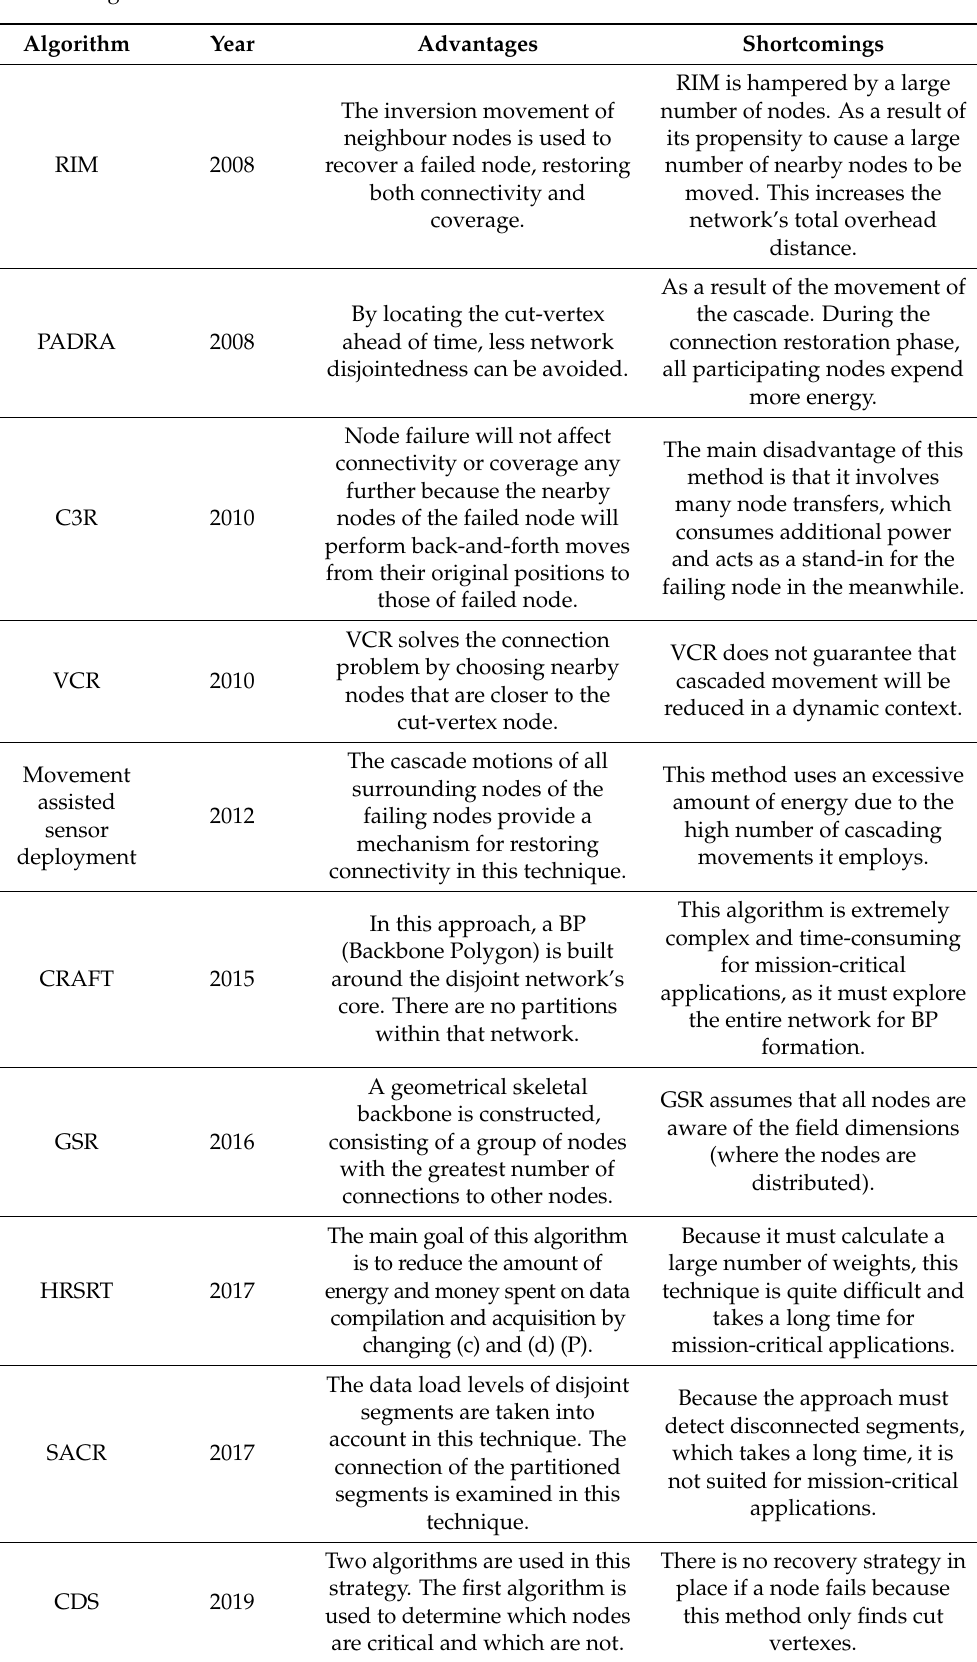
Table 1. Algorithms for related work.